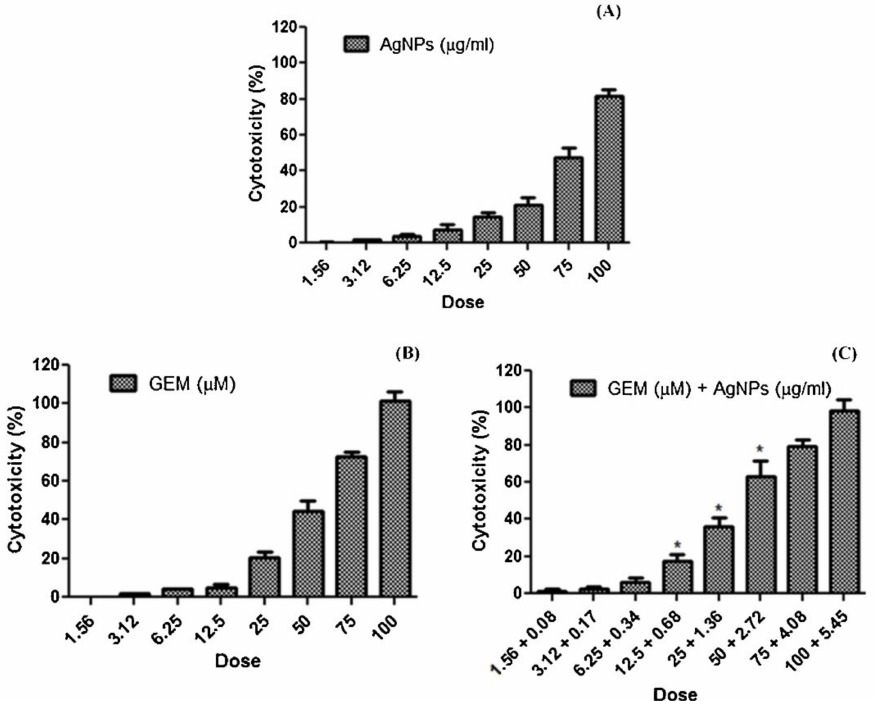
Figure 12. Cytotoxicity studies with AgNPs ( A ), free GEM ( B ), and GEM-AgNPs ( C ) against the breast cancer cell line MDA-MB-453, at concentrations of 1.56, 3.12, 6.25, 12.5, 25, 50, 75, and 100 µ M. (*)—Statistical significance analyzed at the level p < 0.05. Reprinted from [59], with permission from Elsevier,